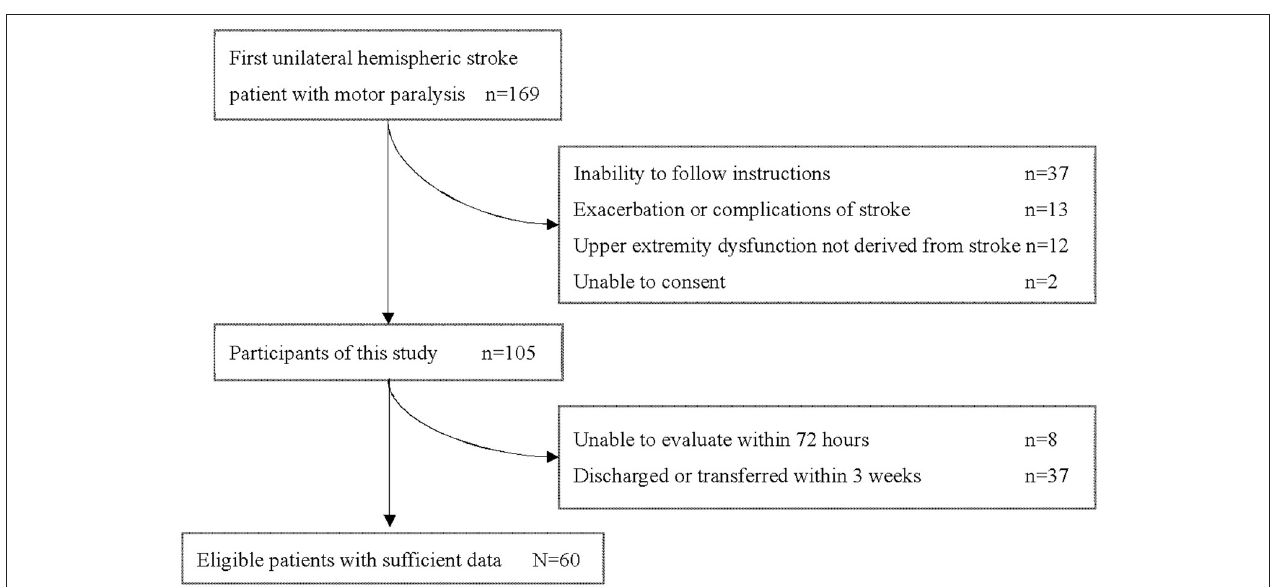
FIGURE 1 | Flow chart of study